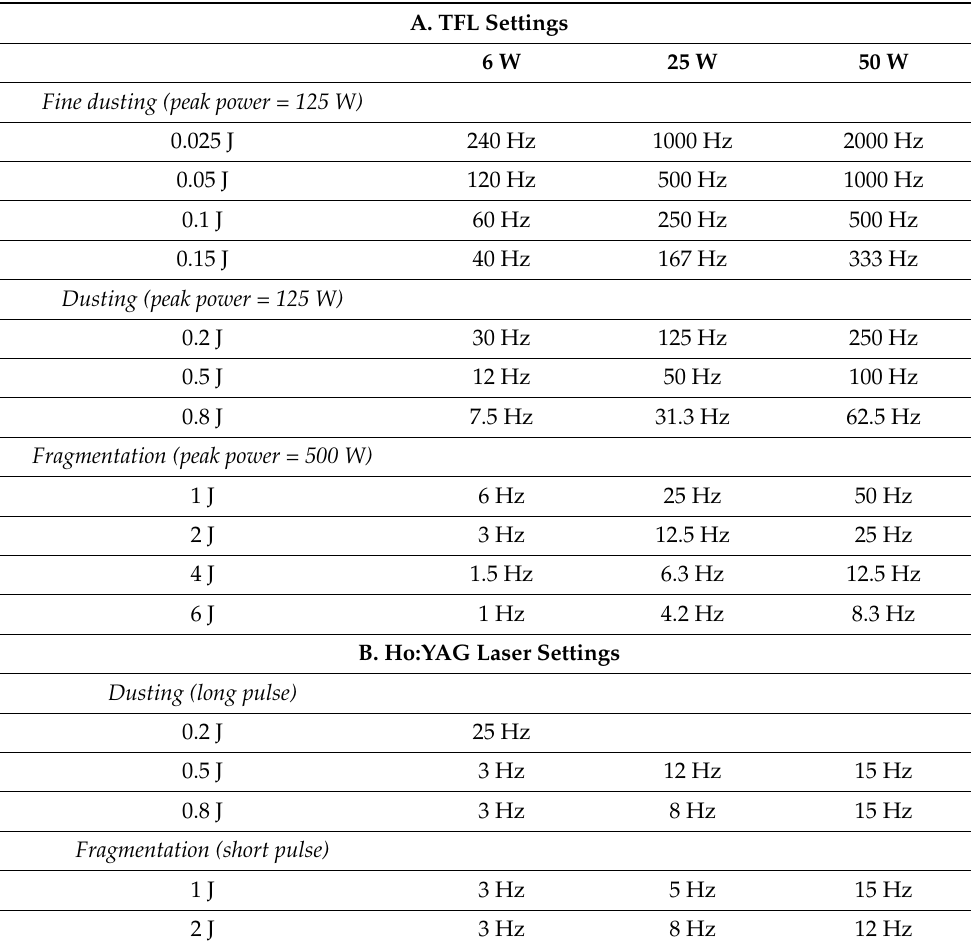
Table 1. ( A ): TFL laser settings; ( B ): Ho:YAG laser